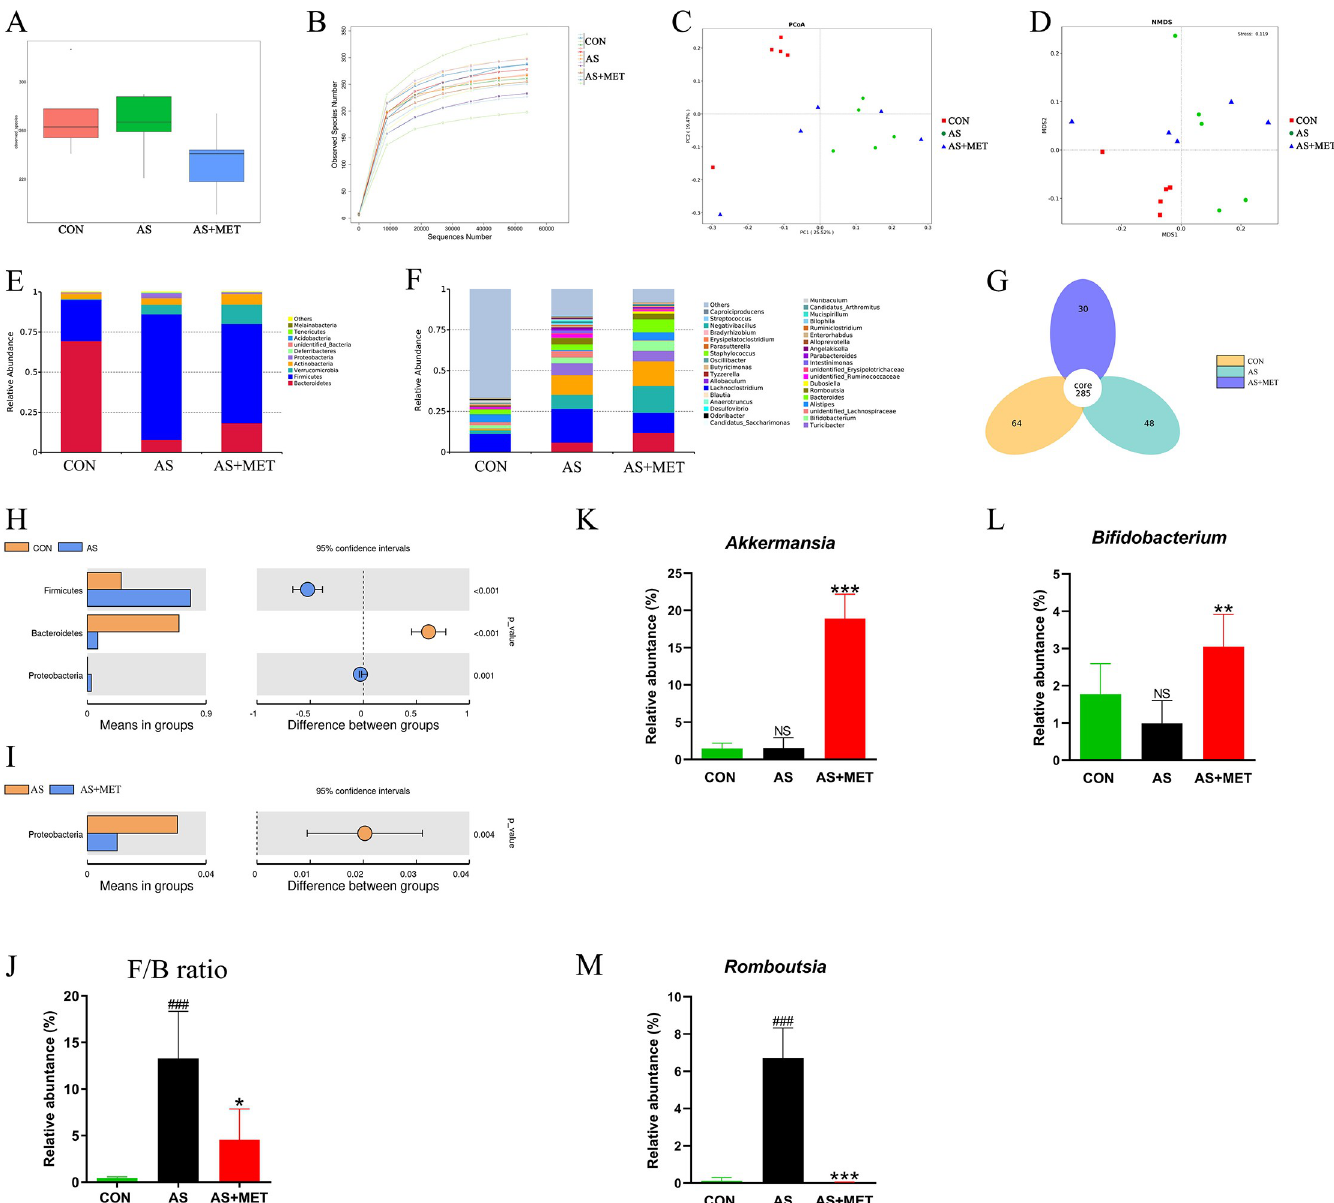
Fig 5. Gut microbial community in fecal samples of different groups. (A) Observed-species index; (B) Rarefaction Curve; (C) PCoA analysis; (D) NDMS analysis; (E, H, I, J) The phylum level; (F, K, L, M) The genus level; (G) Venn diagram. # (CON vs. AS): # p < 0.05, ## p < 0.01, ### p < 0.001. � (AS vs. AS+MET): � p < 0.05, �� p < 0.01, ��� p < 0.001. NS, no significant